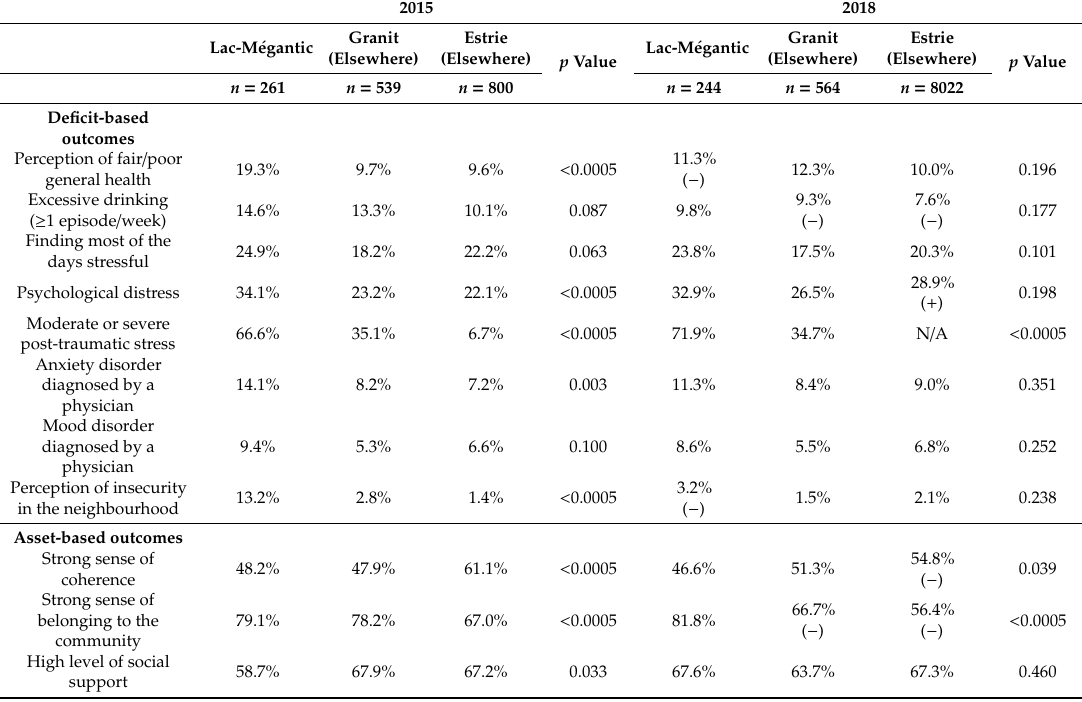
Table 2. Deficit- and asset-based outcomes among a community-based sample of adults according to residential location, two years and five years post-disaster (e.g., Lac-M é gantic train derailment, 6 July 2013), Estrie region, 2015 and